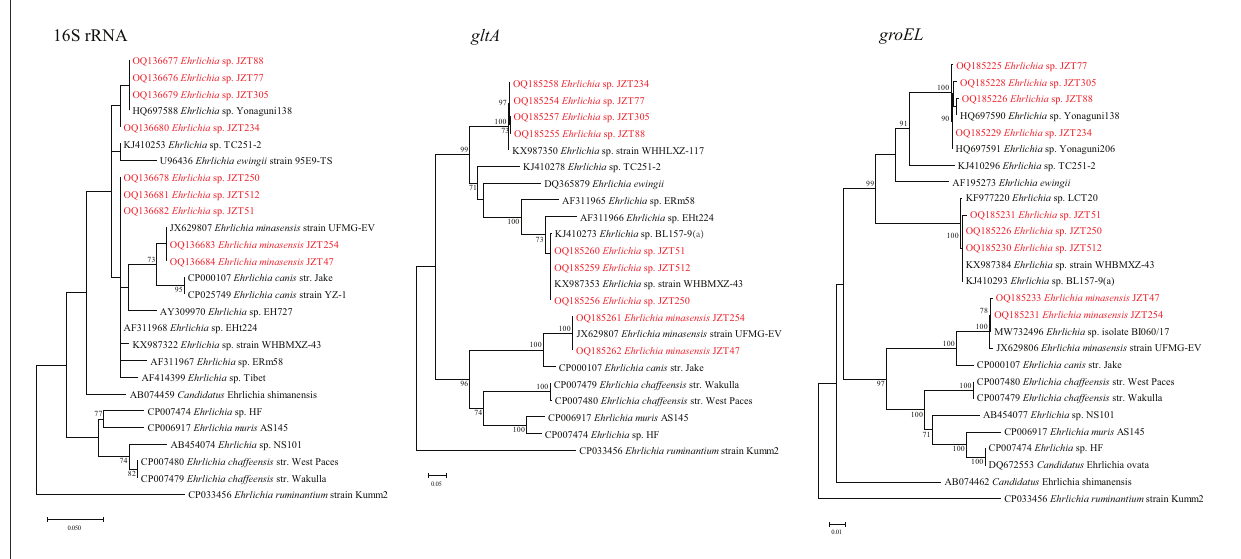
FIGURE5 Phylogenetic trees constructed using PhyML 3.0 based on the nucleotide sequences of the 16S rRNA (1,198 bp), gltA (977 bp), and groEL (1,111 bp) genes of Ehrlichia strains. Sequences obtained in this study are marked in red.